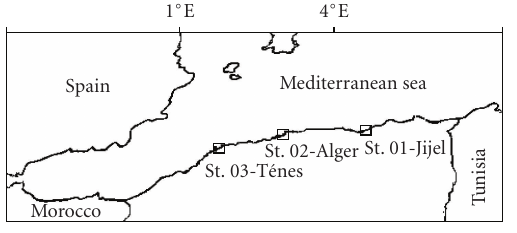
Figure 1: Sampling locations.